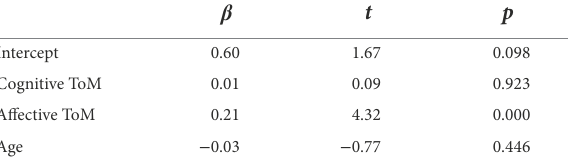
TABLE 8 Results of the multiple linear regression with self-oriented vs. hetero-oriented arguments indicator (response variable) and the cognitive ToM and affective ToM dimensions (independent variables), the covariate being the age variable.